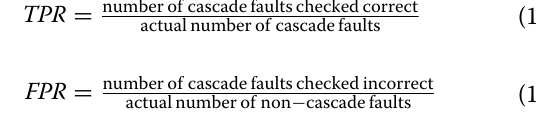
dicts. The P-R curves [12] show the correlation between the recall and precision of the model. The receiver oper- ating characteristic (ROC) curve and P-R curve of the three methods were compared, and the results are shown in Fig. 15. Under different FPR/TPR ratios, the proposed high accuracy. On the Docker historical dataset, the AUC (area under the curve) of the proposed method is 0.908, while the values of LCS and LCS with VMM are 0.802